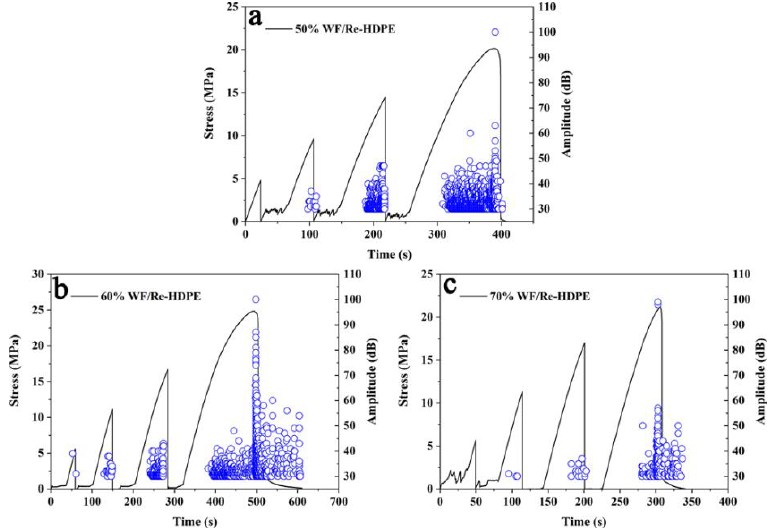
Figure 9. Time-strain curve and AE amplitude of WF/Re-HDPE composites with different WF content. The blue circle represents amplitude in Figure 9.